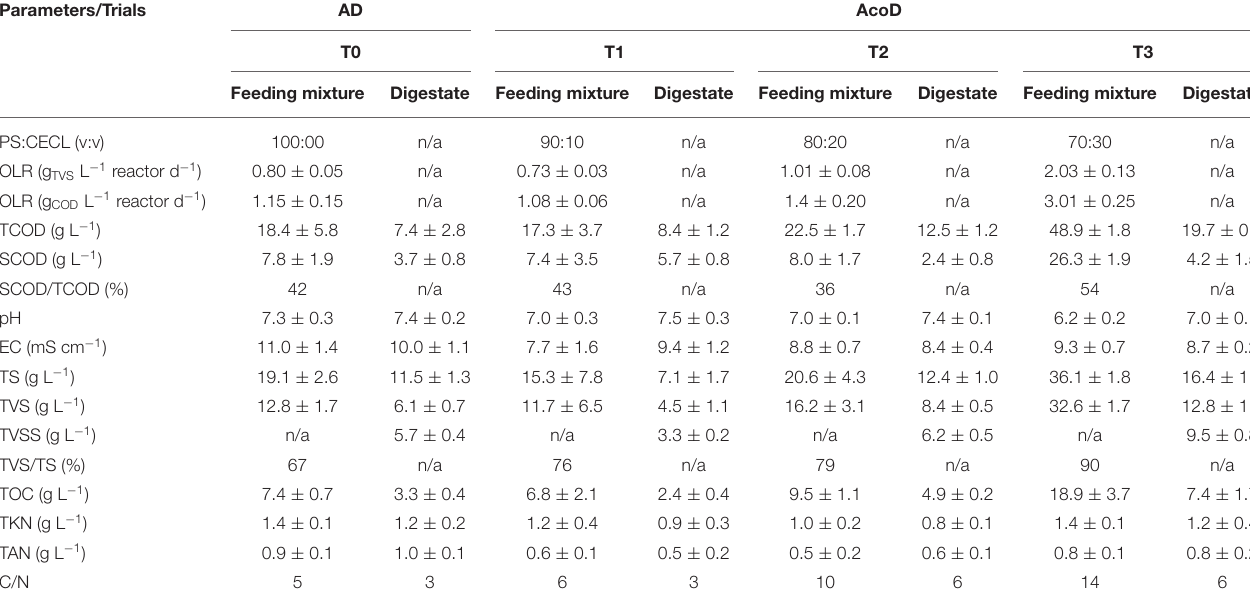
Feeding mixture Digestate Feeding mixture Digestate Feeding mixture Digestate Feeding mixture